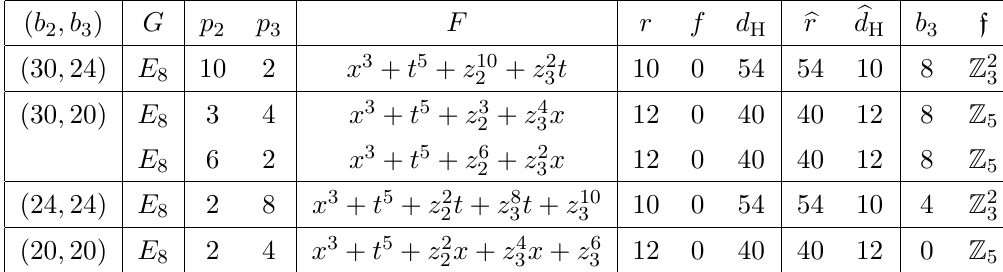
Table 19 . Sporadic models with G = E 8 . Note that there are no solutions with ( b 2 , b 3 ) = (24 , 20) . The two cases for ( b ) = (30 , 20) are 2 , b 3